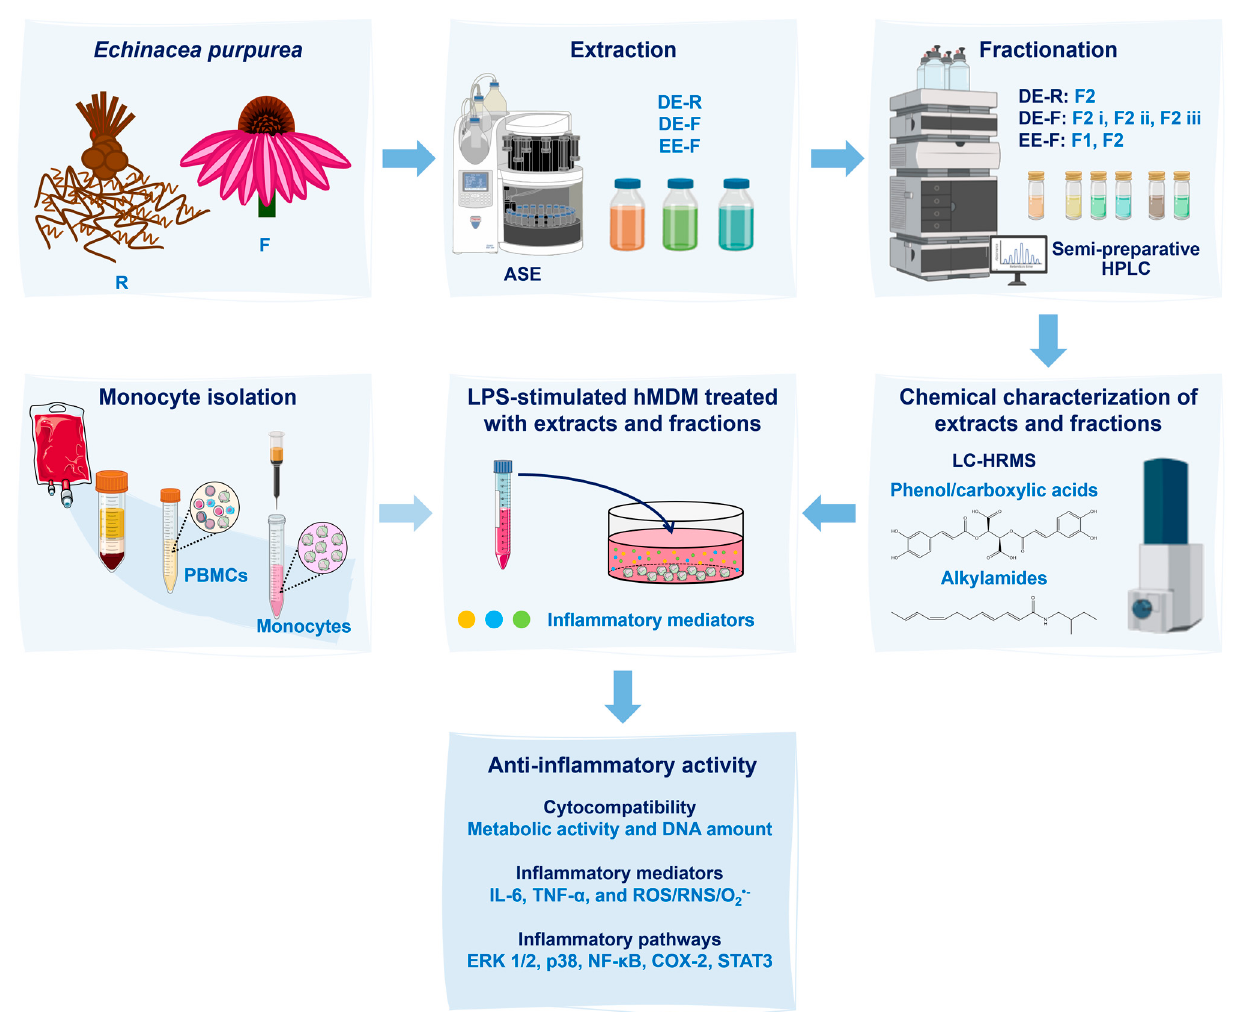
Figure 1. Scheme of the experimental procedure used in this work. Echinacea purpurea root (R) and flower (F) extracts were obtained using an Accelerated Solvent Extractor (ASE). Three extracts